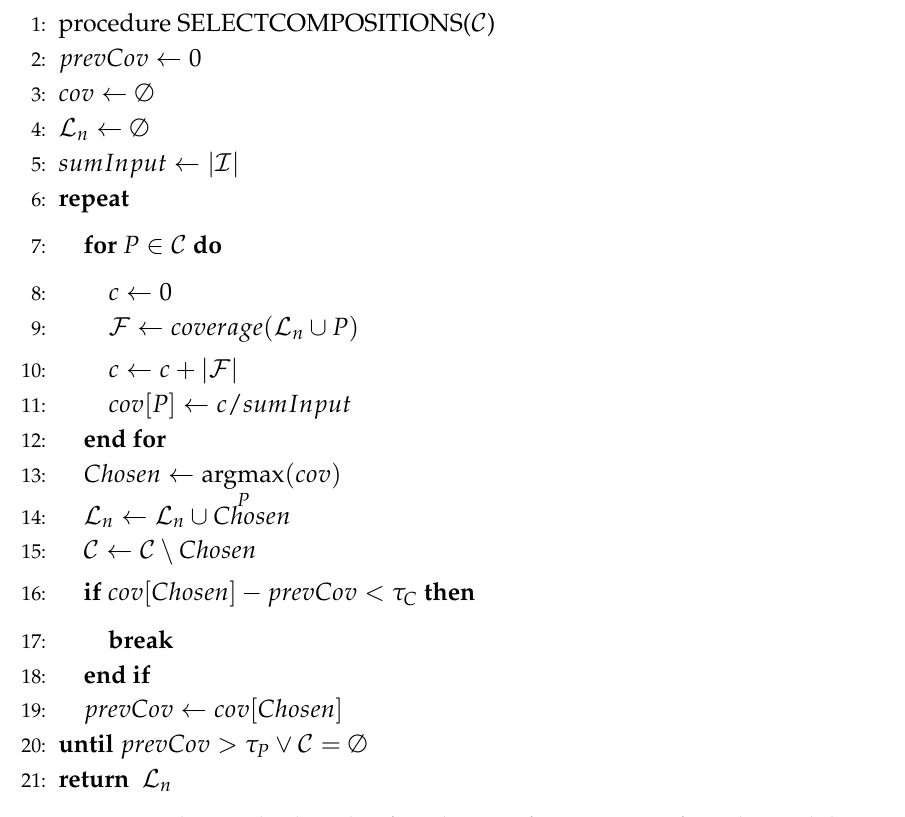
Figure 7. The greedy algorithm for selection of compositions from the candidate set C . Compositions that add the most to the coverage of information in the learning set are